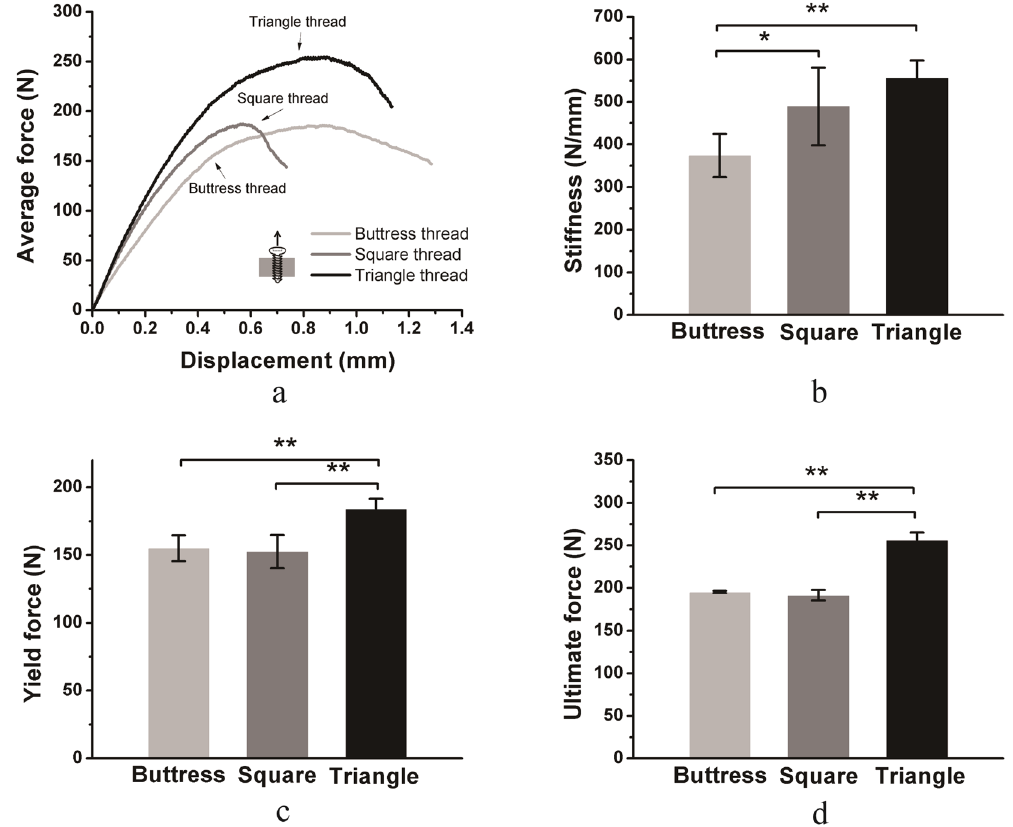
Figure 3. Comparison of the axial pullout strength of screws with different threads. Mean values ± standard deviation of the measured values are presented (N = 5) (one-way ANOVA, *p < 0.05, **p < 0.01). ( a ) Force– displacement curves of the pullout test. ( b – d ) Stiffness, yield force, and ultimate force of the force–displacement